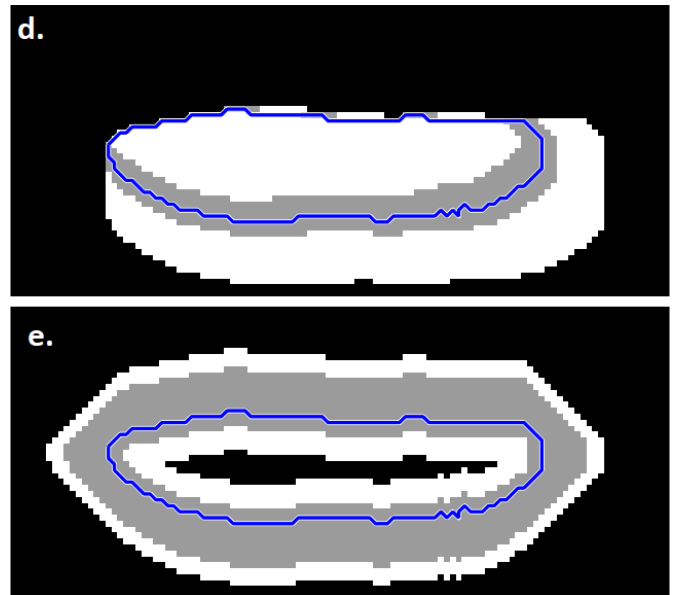
Figure 6. Sensitivity analysis of skin lesion classification procedure. ( a ) Zoomed ultrasound image from Figure 5c, with segmentations denoted using the previously used color scheme (freehand SA, LAR SA, FA). Taking the freehand-based SA lesion border as a reference, the border is shrunk/grown along various regions of the border (( b ): right; ( c ): bottom; ( d ): right and bottom; ( e ): entire region). The classification result is drawn on the corresponding border change, with gray signifying incorrect classification, and white correct